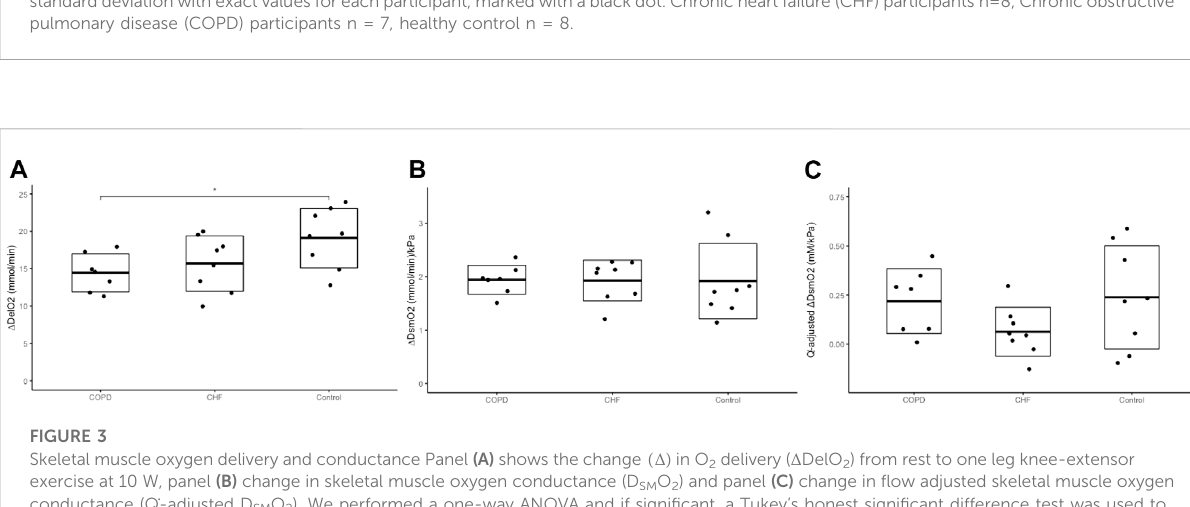
number of perfused capillaries and their length, the capillary fl ow distribution, spatial distribution of capillaries and potential structural changes in the diffusion membrane (Wagner, 2000;